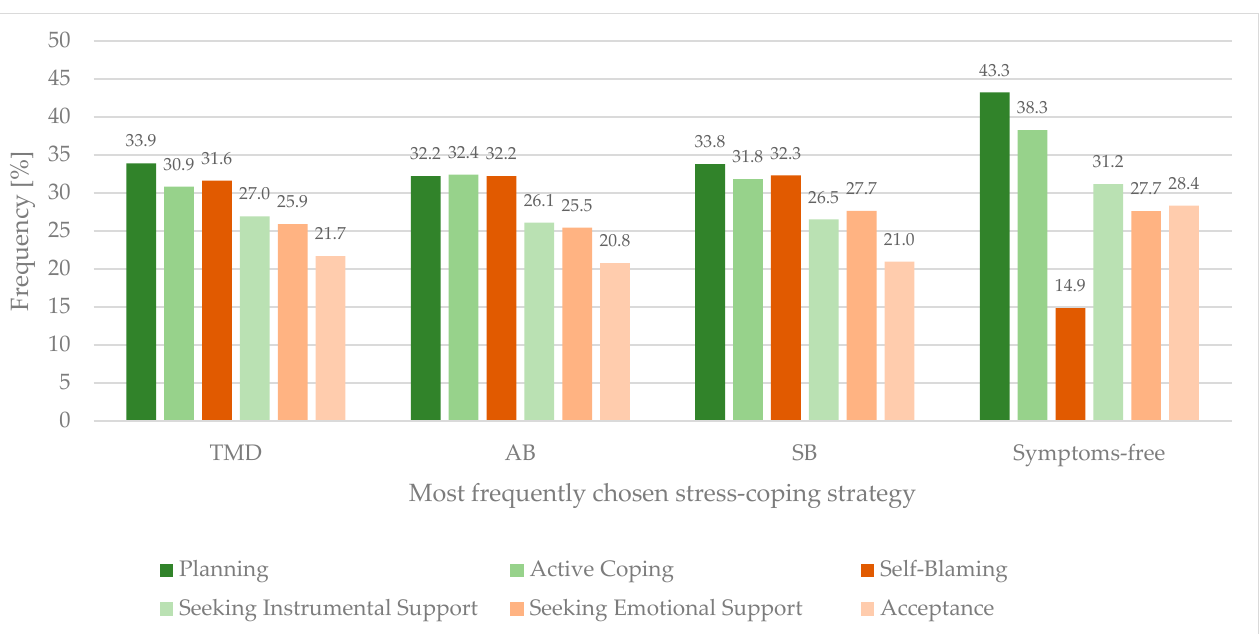
Figure 3. Frequency (percentage of subjects) of choosing coping strategies among subjects presenting TMD symptoms, possible AB and SB.